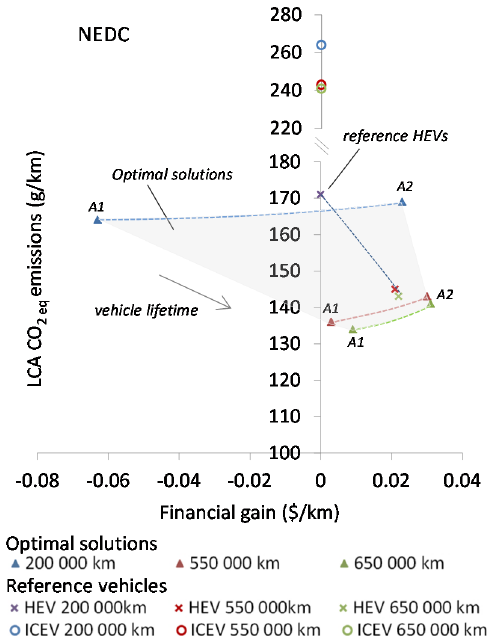
Figure 4. Set of Pareto solutions for multi-objective optimized HEVs concerning NEDC and several life time distances, and comparison with the reference vehicles (ICEV and HEV).